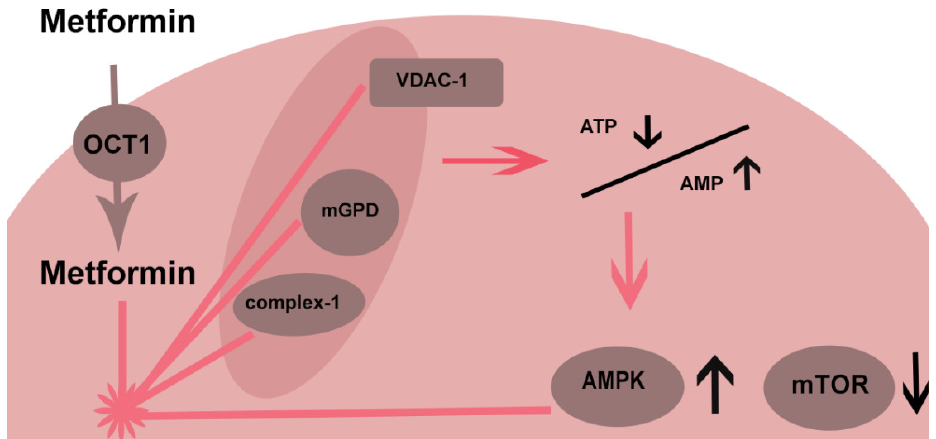
Figure 1. AMPK—AMP protein kinase; OCT—organic cation transporter; mGPD—mitochondrial glycerophosphate dehydrogenase; VDAC—voltage-dependent anion channel; mTOR—mammalian target of rapamycin.